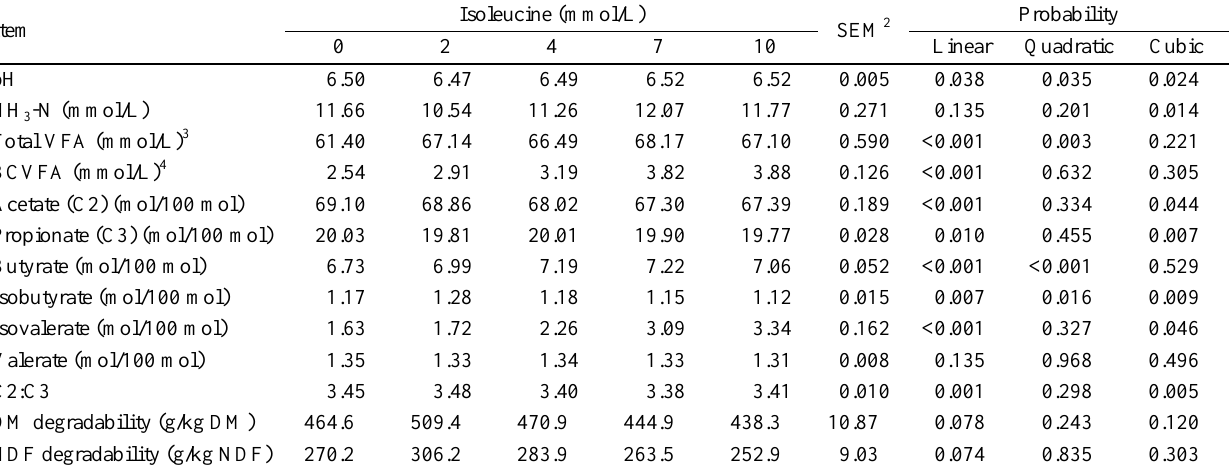
Table 3. Effects of different concentrations of isoleucine on the ruminal fermentation characteristics, DM and NDF degradability of wheat straw in vitro 1